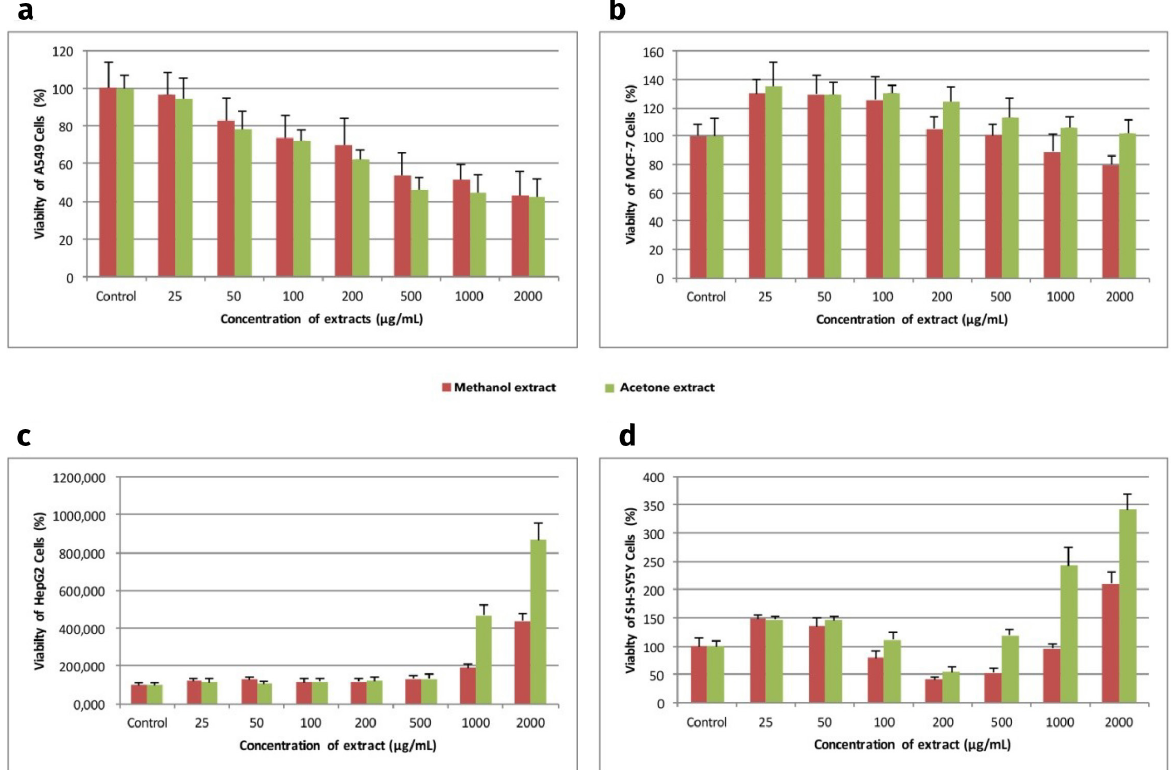
Figure 2. The effect of Verbascum lasianthum Boiss. ex Benth. extracts on cancer cells (A549, MCF-7, HepG2 and SH- SY5Y cell